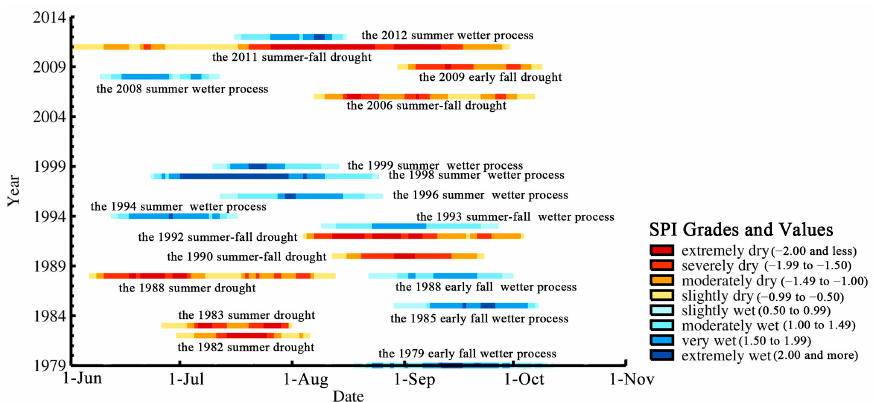
Figure 3. Temporal evolution of identified severe summer and early fall drought and wetter processes from 1979 to 2014 in Southwest China (SWC) based on one-month SPI (SPI1). 3.2. Spatial Distribution of SPI1 and Vertically Integrated Water Vapor Flux Divergence Negative gridded SPI1 covered almost the entire region except for a small northern area (Figure 4a), while the extremely negative values centered on 22.5° N, 105° E. The drought severity deepened gradually from north to south. Figure 4b shows that the slightly positive vertically integrated D( Q ) covered almost the entire region. Two positive SA centers occurred in the southern part, whereas a negative center existed in the northern region. This configuration of vertically integrated D( Q ) anomalies is similar to that of gridded SPI1.